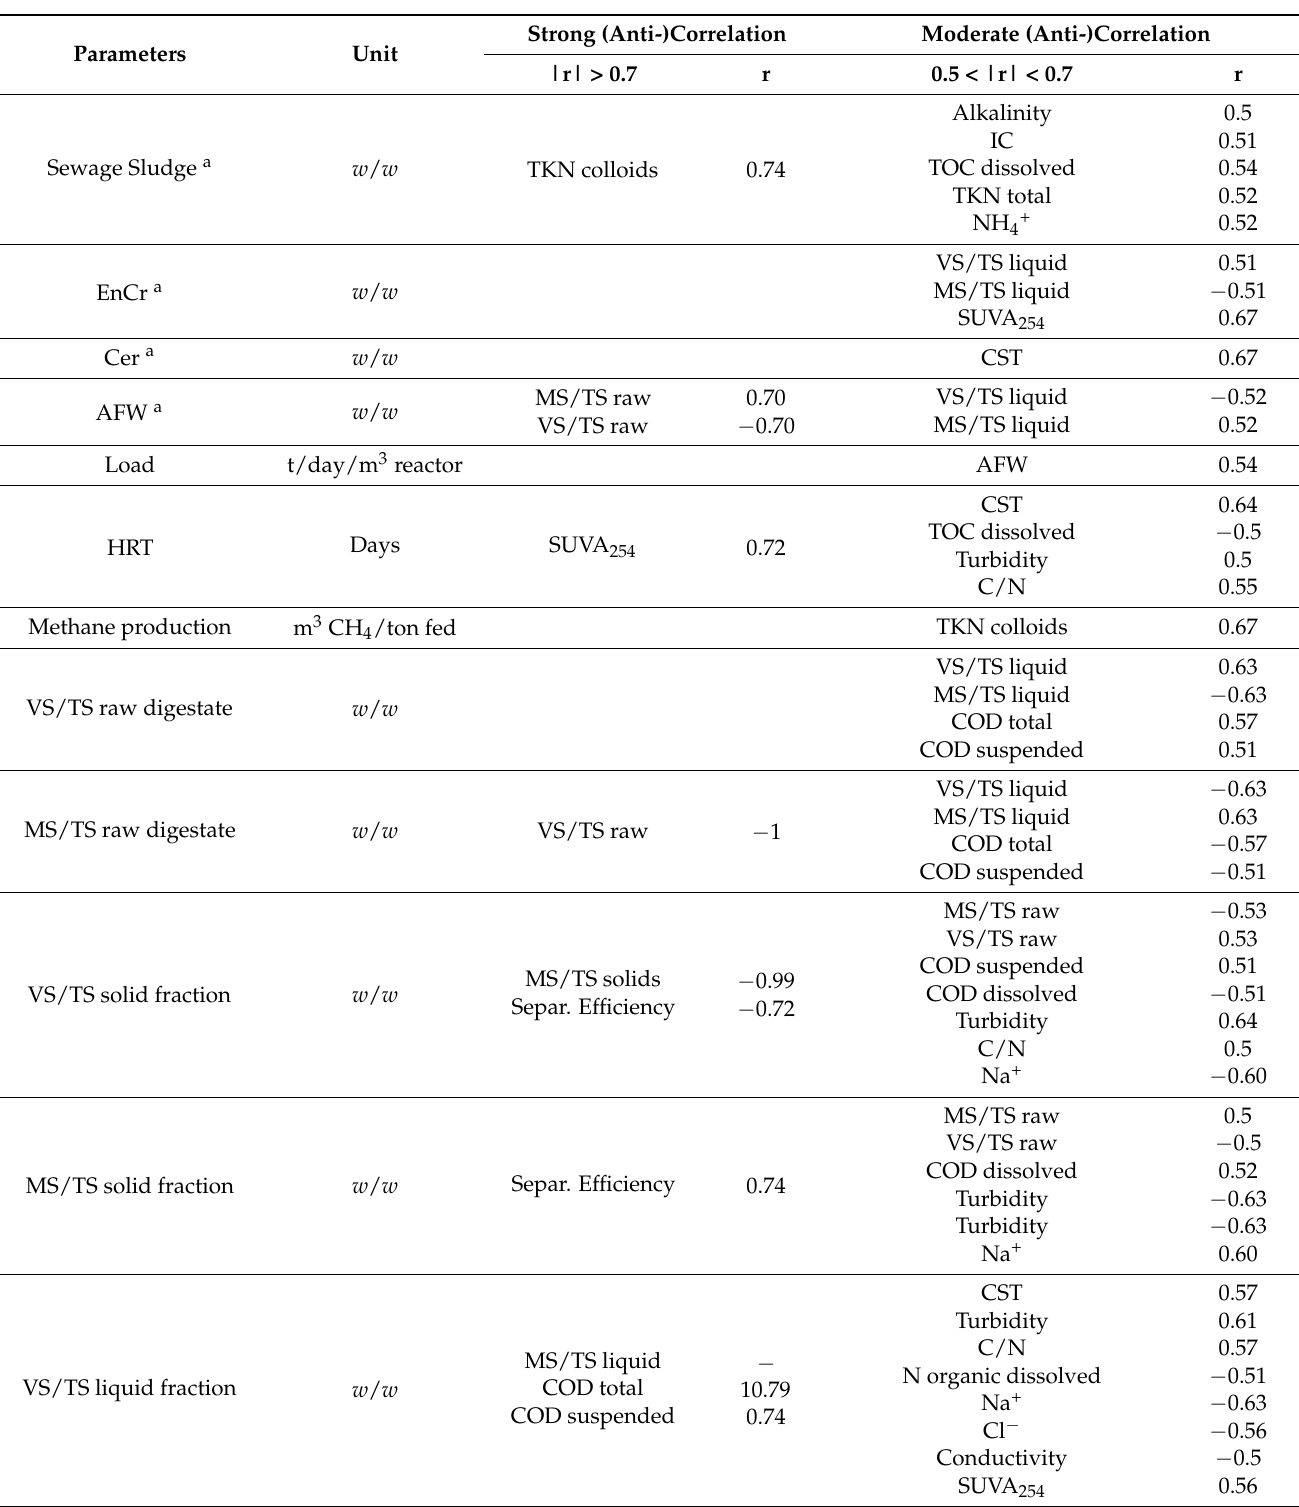
Table 2. Summary of correlations ( p -value <